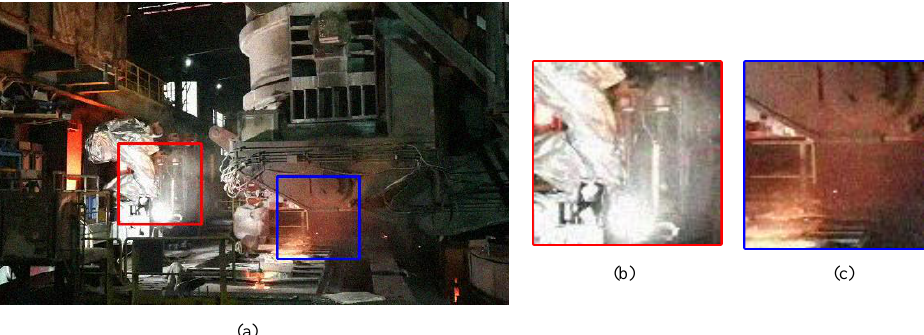
Figure 1. Any vision system in the continuous casting of the steel industry suffers from noise and haze. ( a ) A frame from a continuous casting factory. ( b , c ) Showing that haze and noise lead to low visual